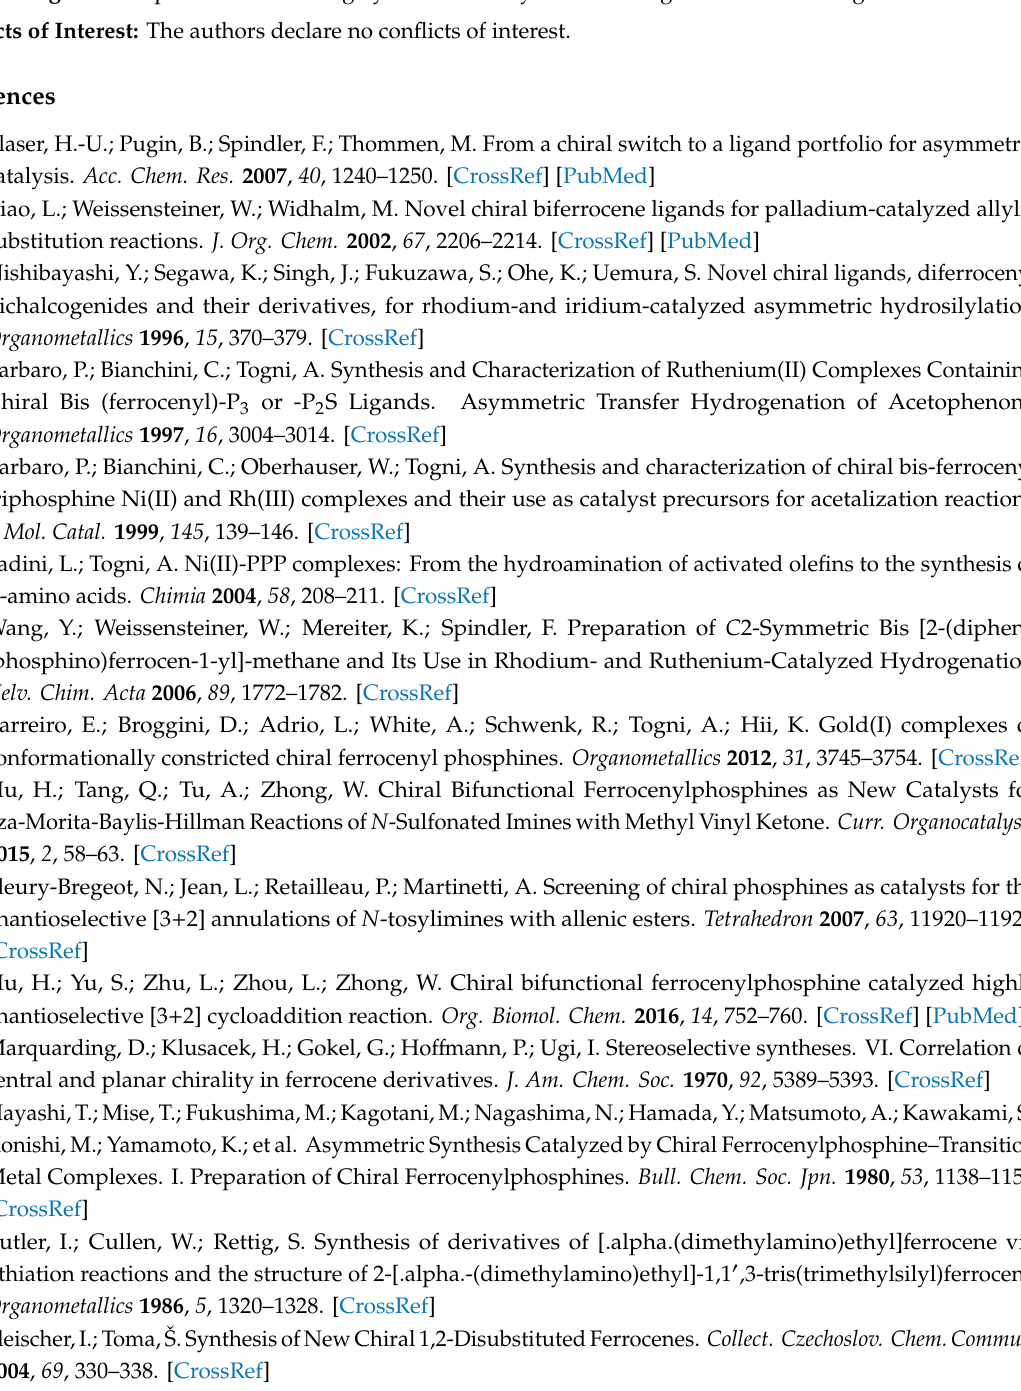
Figure S2: 13 C-NMR spectrum of compound 3 , Figure S3: 1 H-NMR spectrum of compound 4 , Figure S4: 13 C-NMR spectrum of compound 4